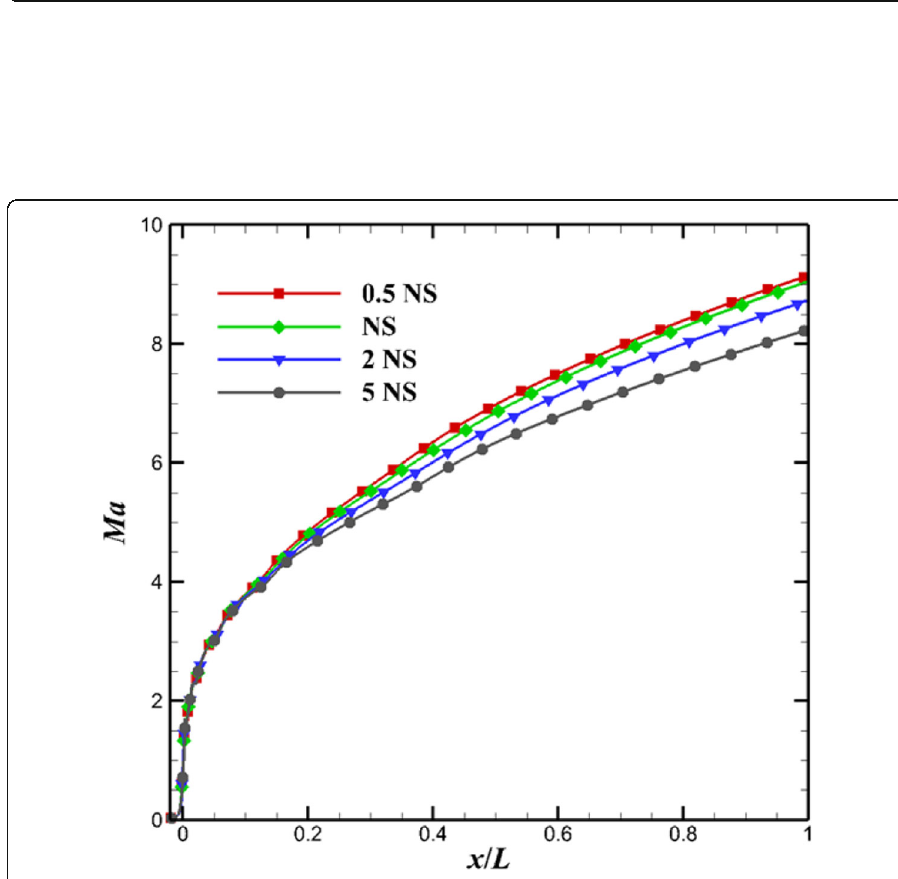
Fig. 11 Comparison of the centerline Mach number distribution based on the HEG